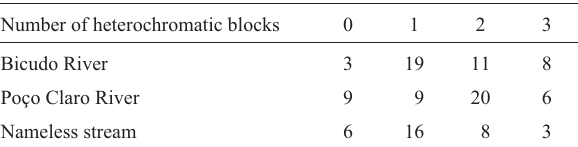
Table 1 - Frequency of specimens with 0, 1, 2, or 3 interstitial heterochro- matic blocks in each sample.